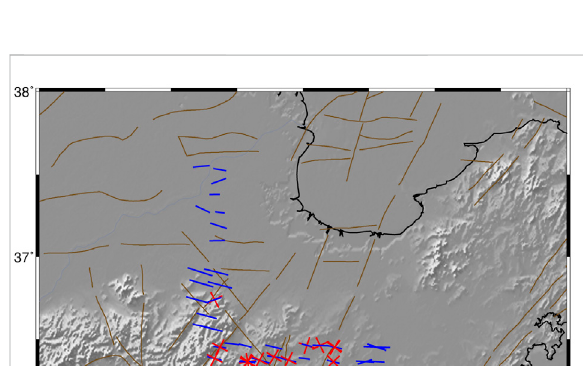
FIGURE 8 Comparison of shear-wave splitting measurements by this study (blue bars and circles) with Zhao and Zheng (2005) (red bars and circles) and Yang et al. (2019) (black bars and circles). The orientation of each short bar denotes the fast direction, whereas the size of each circle is proportional to the splitting time. Thegreenbarsrepresentmaximumhorizontalstress fi eldwith0.2 ° gridding (Heidbach et al., 2018). The red lines denote major active faults (Deng et al., 2002).